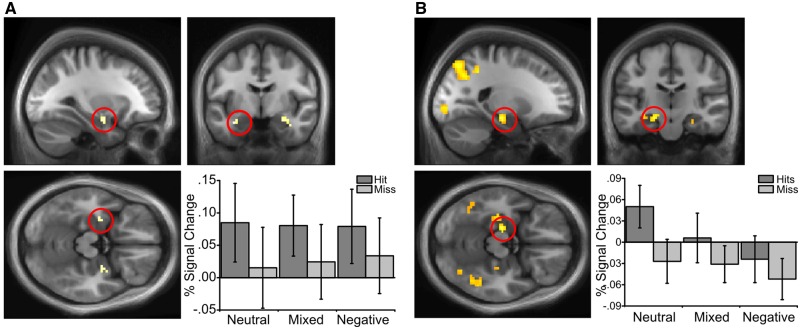
Encoding activity showing subsequent memory effects across emotional valence conditions. (A) A contrast of subsequent item hits vs misses identified the left amygdala (P <  0.001 uncorrected; −33, −6, −21). (B) Activations in the left anterior hippocampus predicted subsequent associative hits compared with misses (P < 0.05 FWE SVC; −21, −18, −15). Effects displayed on group average brains and thresholded at P < 0.005 uncorrected for display purposes.